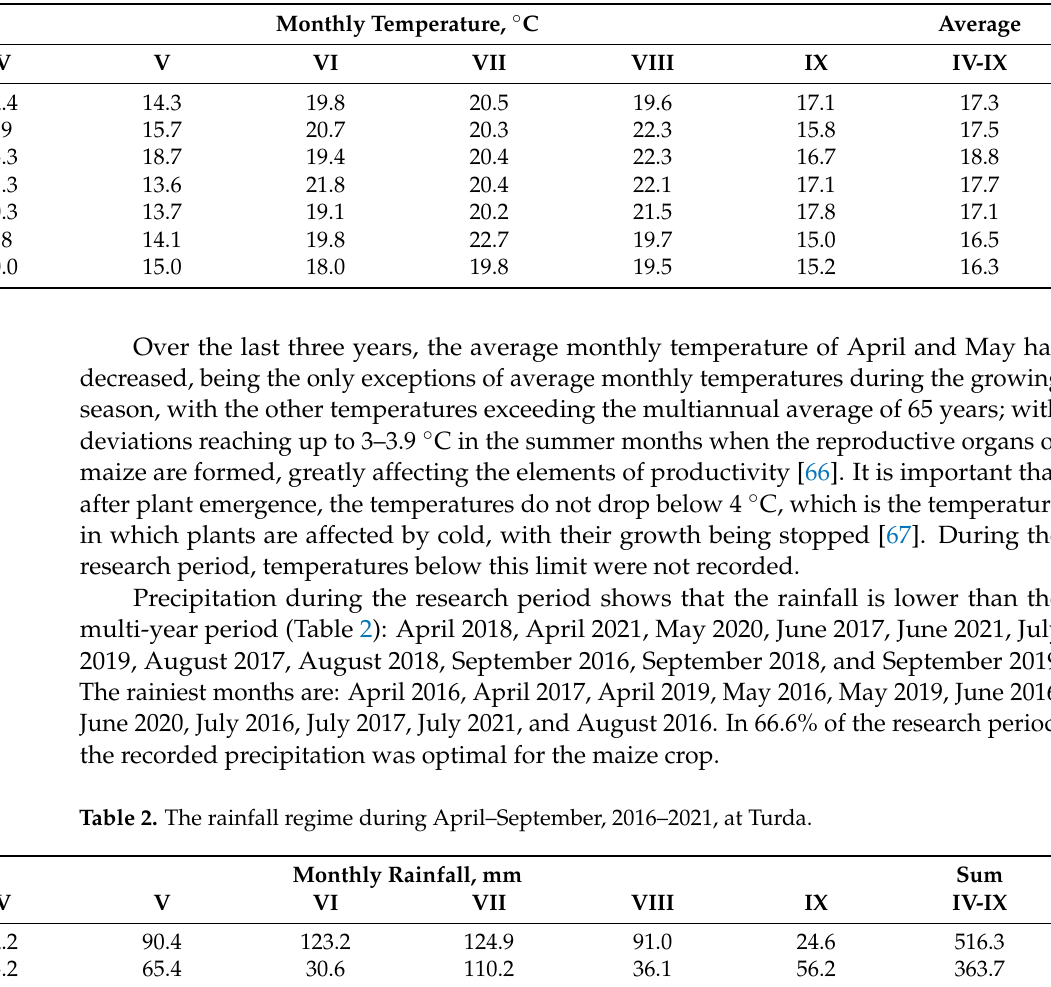
Table 1. Thermal regime during April–September, 2016–2021, at Turda.